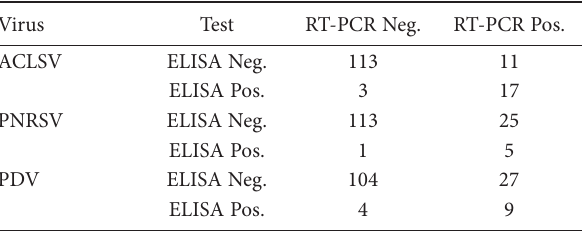
Table 4. Comparison of diagnostic results obtained from RT-PCR and ELISA for the detection of apple chlorotic leaf spot virus (ACLSV), Prunus necrotic ringspot virus (PNRSV), and prune dwarf virus (PDV). A total of 72 trees were tested by each method in 2018, and again in 2020 (144 test results). Petals were used as starting material. Neg. = negative; Pos. = positive.